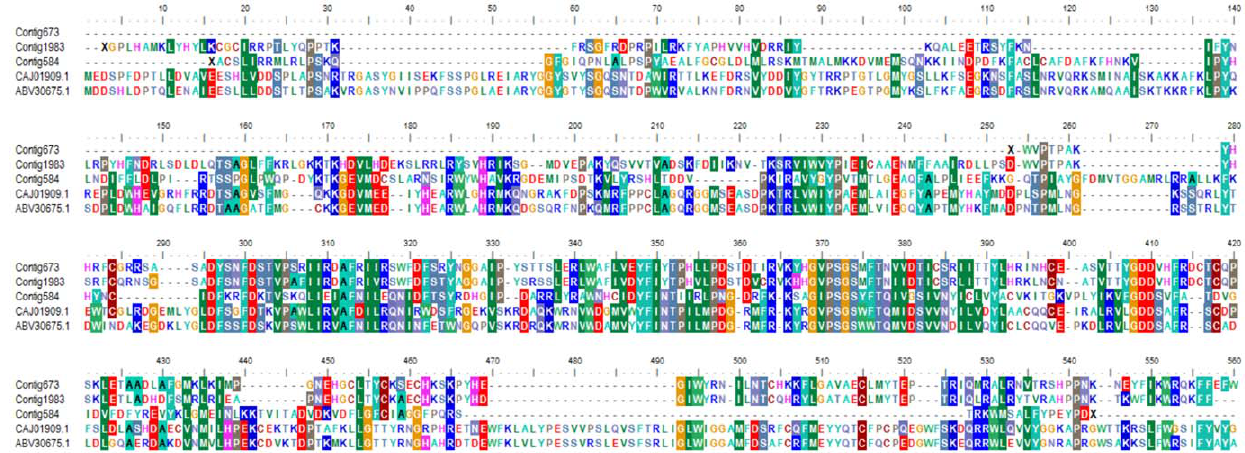
Figure 5. Sequence alignment of three contigs with BLASTX matches to the RDRP of PenicilliumstoloniferumvirusS , GenBank accessions CAJ01909.1 and AY156521.2. Shading at each position indicates amino-acid similarity among at least 50% of the residues, based on the BLOSUM62 matrix. Alignment performed with ClustalW using default settings.